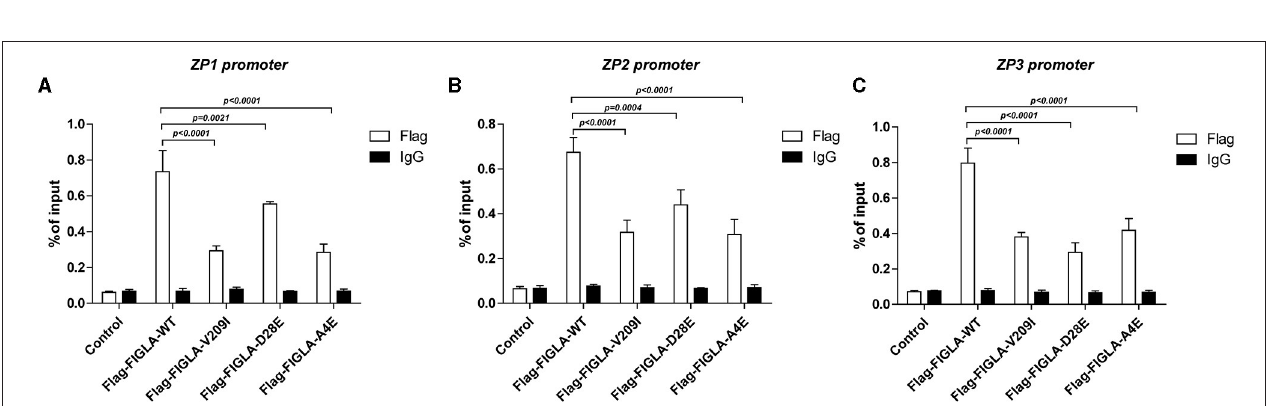
FIGURE 4 | FIGLA mutation impairs binding of FIGLA to the promoter regions of ZP1, ZP2, and ZP3 . HEK293 cells were transfected with Flag-FIGLA-WT, Flag-FIGLA-V209I, Flag-FIGLA-D28E, or Flag-FIGLA-A4E. Interaction of FIGLA with the promoter region of ZP1 (A) , ZP2 (B) , and ZP3 (C) was detected by chromatin immunoprecipitation assays. Results were mean ± SD for three individual experiments which, for each condition, were performed in triplicate.